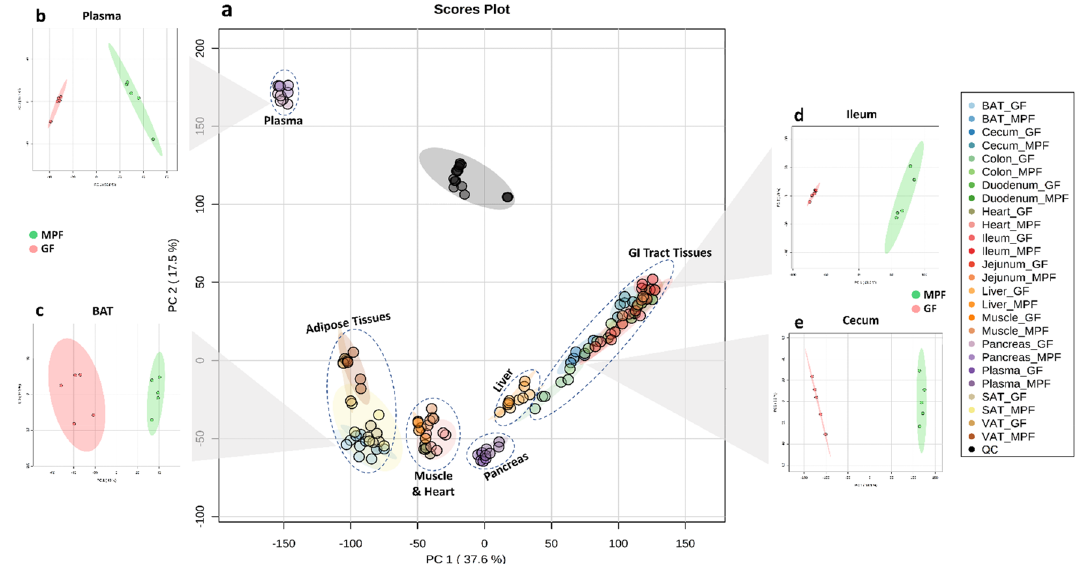
Figure 2. Principal component analysis (PCA) of the profiling data shows separation between tissues and mice groups. Data shown for reverse phase (RP) and HILIC modes with both positive and negative ionization; ( a ) PCA of all the analyzed samples from all tissues, ( b ) PCA of plasma samples from the GF and MPF mice, ( c ) PCA of BAT samples from the GF and MPF mice, ( d ) PCA of ileal samples from the GF and MPF mice, ( e ) PCA of cecal samples from the GF and MPF